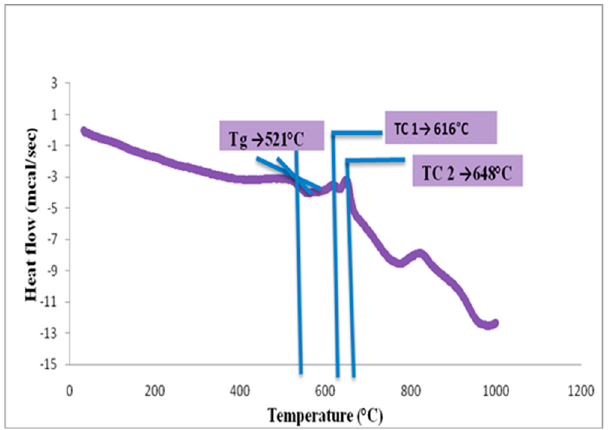
Figure 2. Di ff erential scanning calorimetry (DSC) analysis of the A1 Glass. Figure 2. Differential scanning calorimetry (DSC) analysis of the A1 Glass.